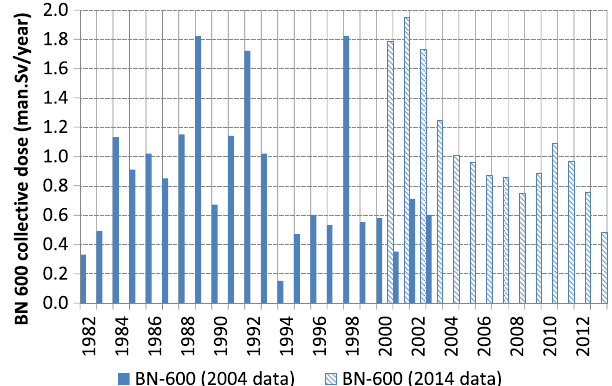
Fig. 7. Evolution of the collective dose for the BN 600 reactor between 1982 and 2013 [21,22].